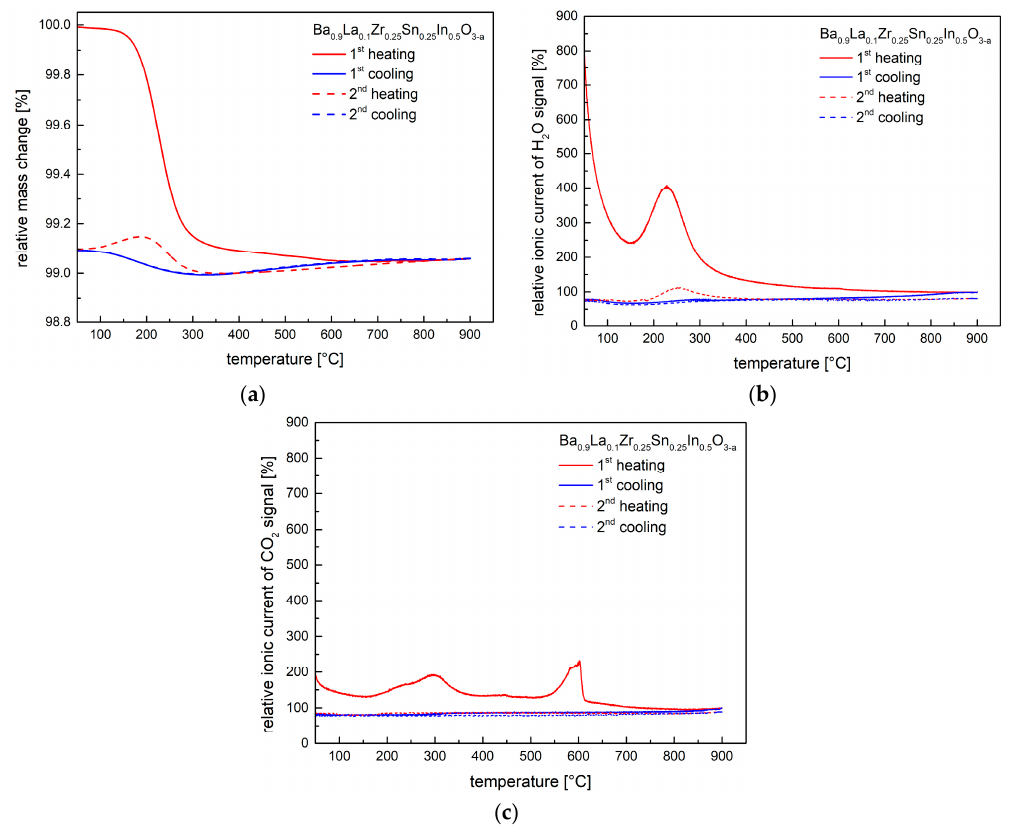
Figure 6. ( a ) Thermogravimetric characteristics for the hydrated at 250 °C Ba 0.9 La 0.1 Zr 0.25 Sn 0.25 In 0.5 O 3 − a material, recorded in synthetic air during two cycles; ( b ) Relative ionic current of H 2 O-related signal recorded by mass spectrometer, corresponding to the performed TG studies; ( c ) Relative ionic current of CO 2 -related signal recorded by mass spectrometer, corresponding to the performed TG studies.